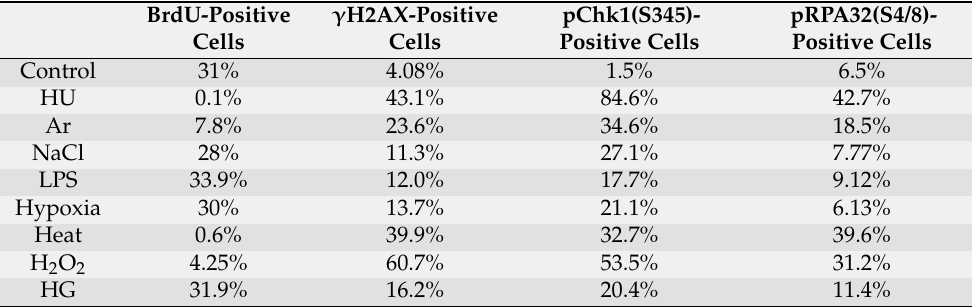
Figure 2. Various biological stresses influence DNA replication to different extents. ( A ) U2OS cells were treated with indicated biological stresses for 3 h. The nucleotide analog BrdU was added for 15 min before the cell harvest. Cells were then stained with anti-BrdU antibody and propidium iodide (PI); 1 × 10 4 cells were analyzed by flow cytometry. Representative images were shown. Upper, BrdU incorporation (DNA synthesis); lower, cell cycle (DNA content). ( B ) Fractions of BrdU-positive cells in stress-treated cells (gated in A) were measured and are presented. Table 1. Fractions of cells positive for BrdU, γ -H2AX, pChk1(S345), and pRPA32 in all the cell popula- tion in response to various biological stresses. The values are based on FACS data in Figures 2 and 1F.